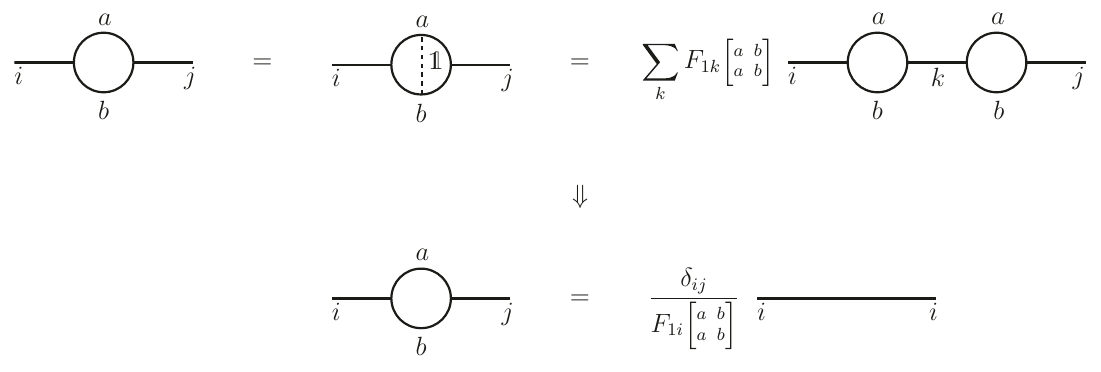
Figure 5 . Defect bubble network. When no operators are present inside, the topological bubble can be shrunk to zero size, yielding a numerical factor symmetric under the exchange of a and b labels.